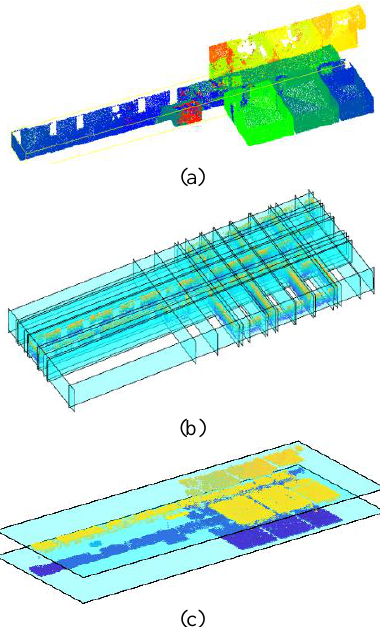
Fig. 6. Extraction of building structures of the TUB1 building: (a) the point cloud (the ceiling is removed for a better visualization), (b) vertical structures (c) horizontal structures.